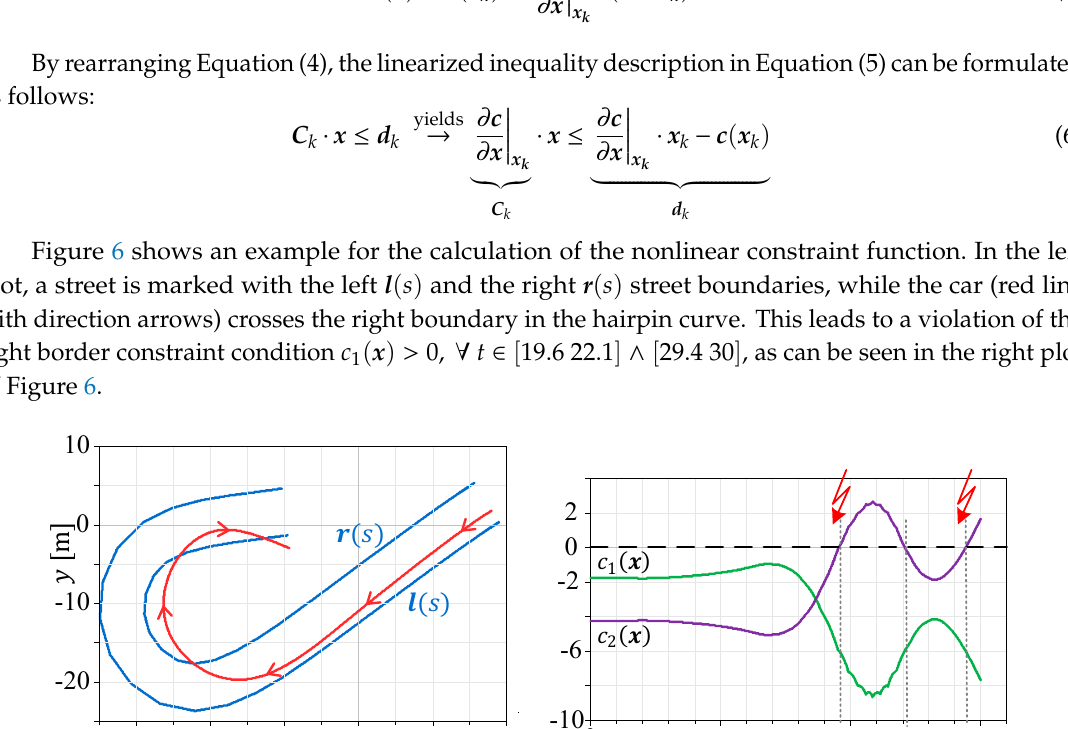
Figure 6. Example path with boundary violation ( Left ) and constraints evaluation ( Right ).